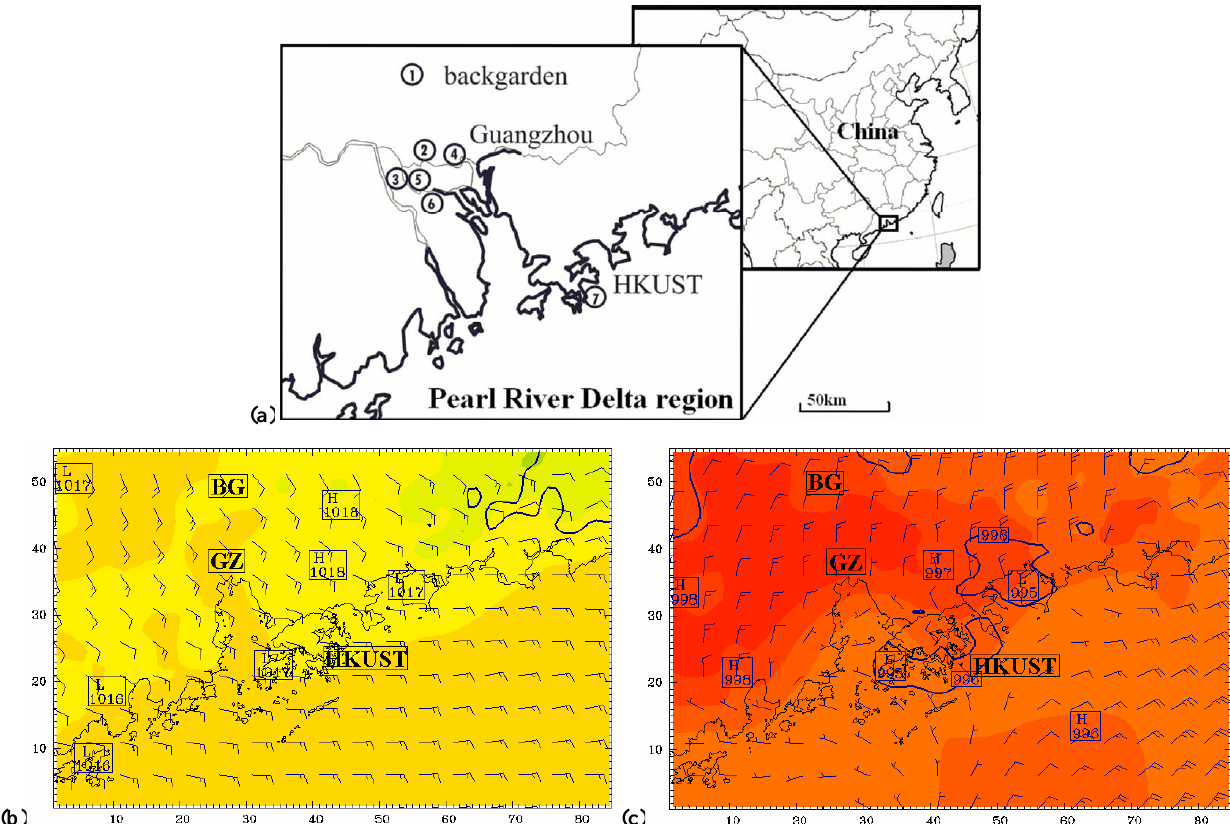
Fig. 1. (a) Locations of five urban sites, one suburban site, and one rural site in the Pearl River Delta region. 1, Rural site at Backgarden; 2, Guangdong Province Meteorological Bureau (GDMB), Yuexiu District; 3, Liwan station; 4, Huangpu station; 5, Haizhu station; 6, Panyu; and 7, HKUST, suburban site in Hong Kong. Sites 2–6 are in the urban area of Guangzhou. (b) Horizontal wind vector map during a HKUST winter sampling day (10 January 2008). (c) Horizontal wind vector map during a BG sampling day (3 July 2006). The wind vector maps were generated by MM5 model based on local surface wind observations in the PRD region (Credit: Environmental Central Facility, HKUST, http://envf.ust.hk/). The color contour indicates the surface temperatures in the region. The surface temperatures ranged from 18 to 22 ◦ C on the winter sampling days and 30 to 36 ◦ C on the summer sampling